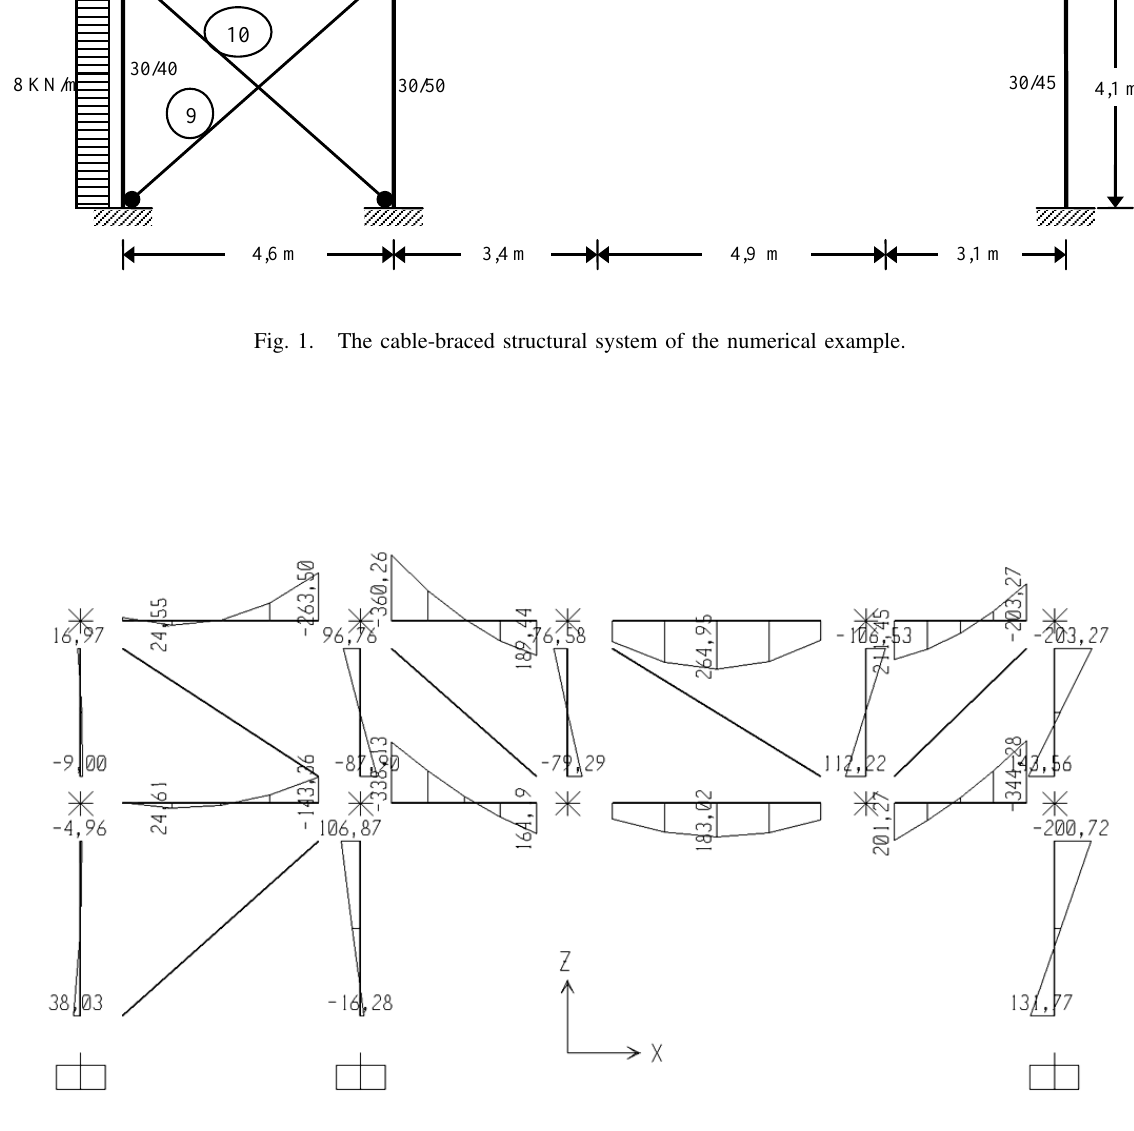
Fig. 2. Bending moments diagram (in kNm ) for the frame with the 5 active cable-elements No 2,4,6,7 and